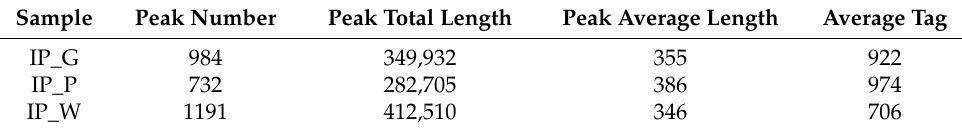
Table 3. Peak information